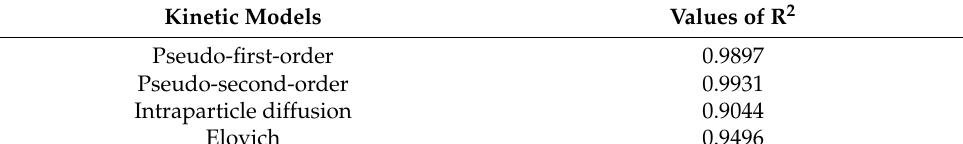
Table 9. The R 2 values of the kinetics for carmine adsorption on rGO/Fe/Cu nanohybrids. Kinetic Models